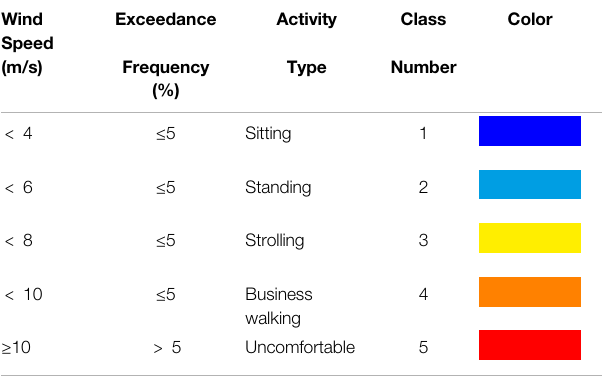
Frontiers in Built Environment |